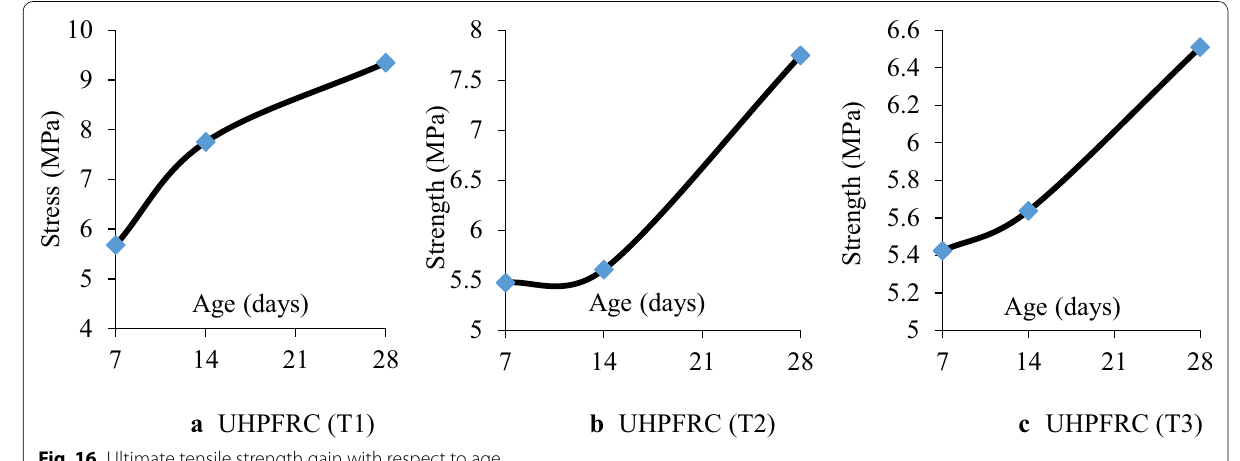
Fig. 16 Ultimate tensile strength gain with respect to